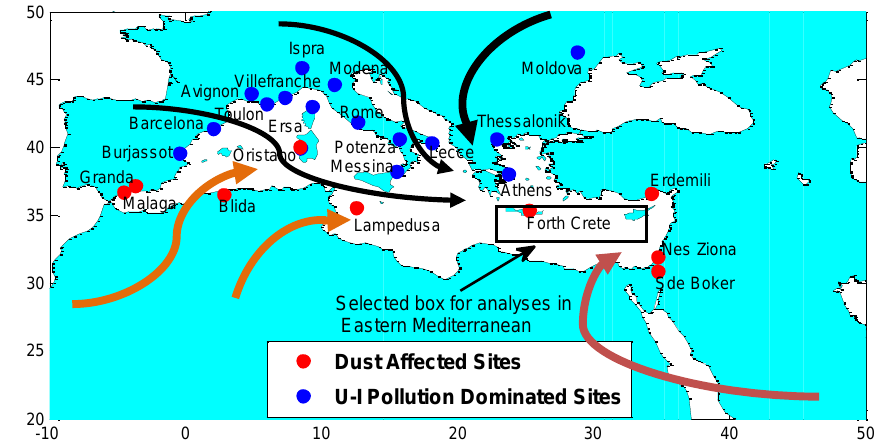
Figure 1. Classification of AERONET sites based on dominant aerosol types, which are likely to affect aerosol properties over the Mediter- ranean region. Red circles are used for dust affected sites and blue circles are used for urban-industrial (U-I) pollution dominated sites. Sites were selected based on data volume, geographic location, and primary aerosol source region. The rectangular box in the eastern Mediter- ranean presents our region of interest (ROI). The different color curved arrows show the schematic wind trajectories at different altitudes/time period during the summer season, 2010. The black arrows show transport of pollution from Europe, whereas light brown and dark brown show transport of dust particles from African and Arabian deserts, respectively. Fig. 2